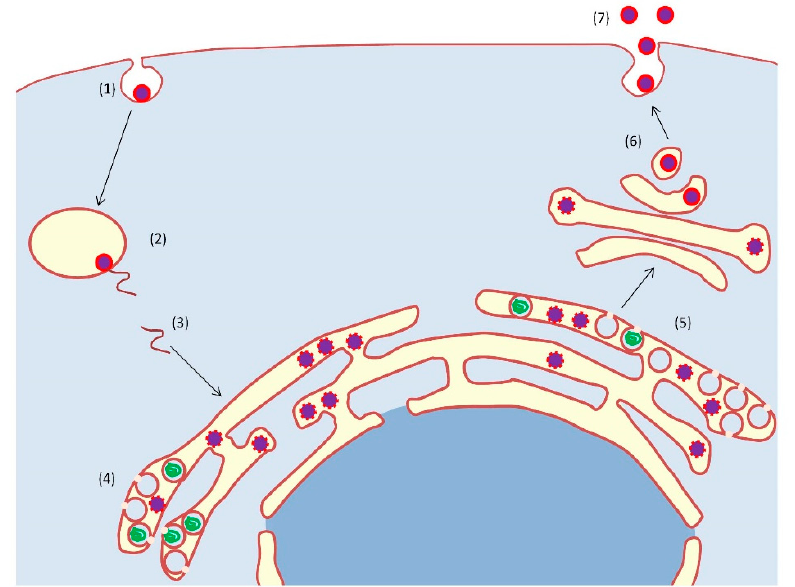
Figure 2. Schematic representation of flaviviral infection. Viral particles enter the cell via receptor-mediated endocytosis (1). The acid environment of endosomes allows viral and endosomal membranes fusion (2), and the subsequent release of viral RNA into the cytosol (3), supporting genome replication and particle biogenesis (4). Viral RNA is translated and processed to produce viral proteins (5), which travel through the Golgi apparatus (6), allowing particle release (7).